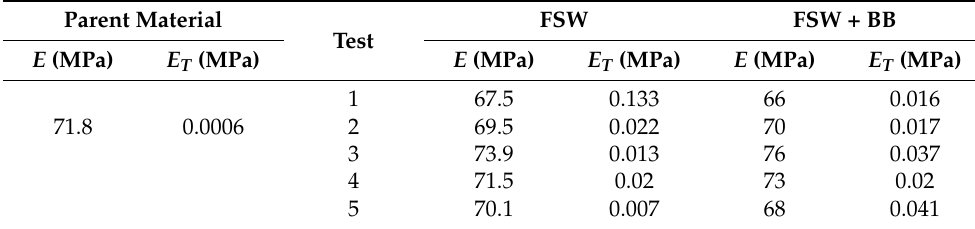
Table 4. Measured E and E T for FSW and FSW + BB specimens. Parent Material